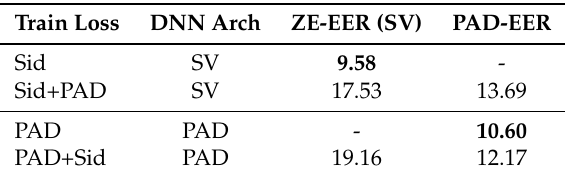
Table 4. Experimental results showing that the required discriminative information differs for SV and PAD (Sid: speaker identification; PAD: presentation attack detection; Int: integrated speaker verification). Numbers in bold represent the best results.